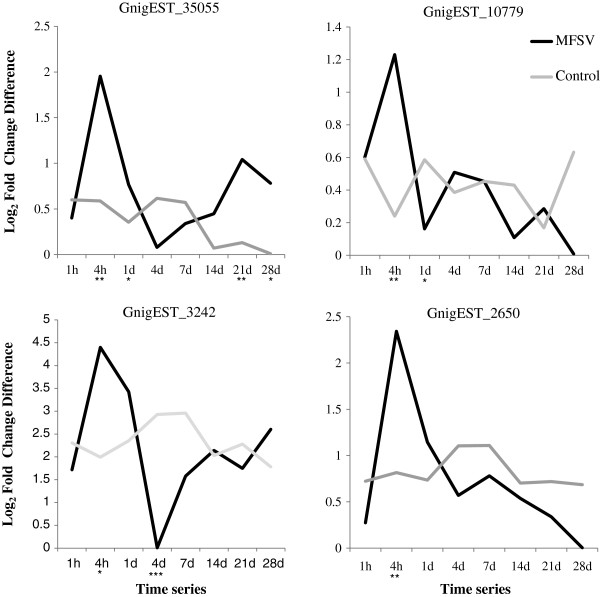
Transcription profiles of GnigEST-35055, 10779, 3242, and 2660 for newly emerged adult G. nigrifrons females fed on MFSV-infected and healthy (control) maize at eight time points over a four-week window. Relative log2-fold gene expression values are represented on the y-axis, and the time points are represented on the x-axis. Significant expression differences between treatments at each time point are denoted below the x-axis. P-values are indicated as *, P < 0.05; **, P < 0.01; ***, P < 0.001.